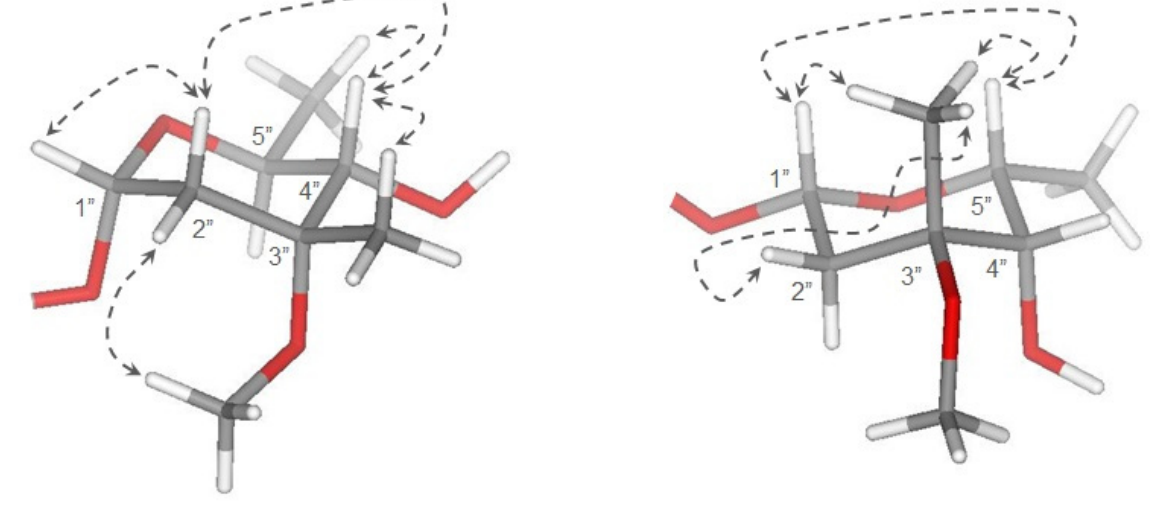
Figure 1. Conformation of cladinose sugar in 3 and 4 with most important nOe interactions (not